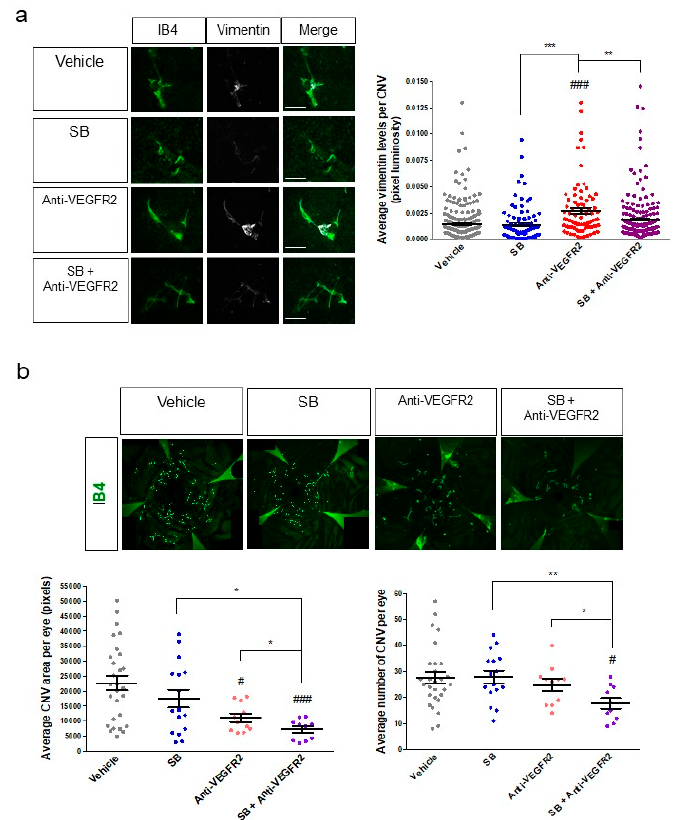
Figure 7. Inhibition of VEGFR2 as a solo treatment promotes EndoMT, whereas anti-VEGFR2 therapy in combination with inhibition of EndoMT / fibrosis reduces CNV area and CNV number in a mouse model of wet